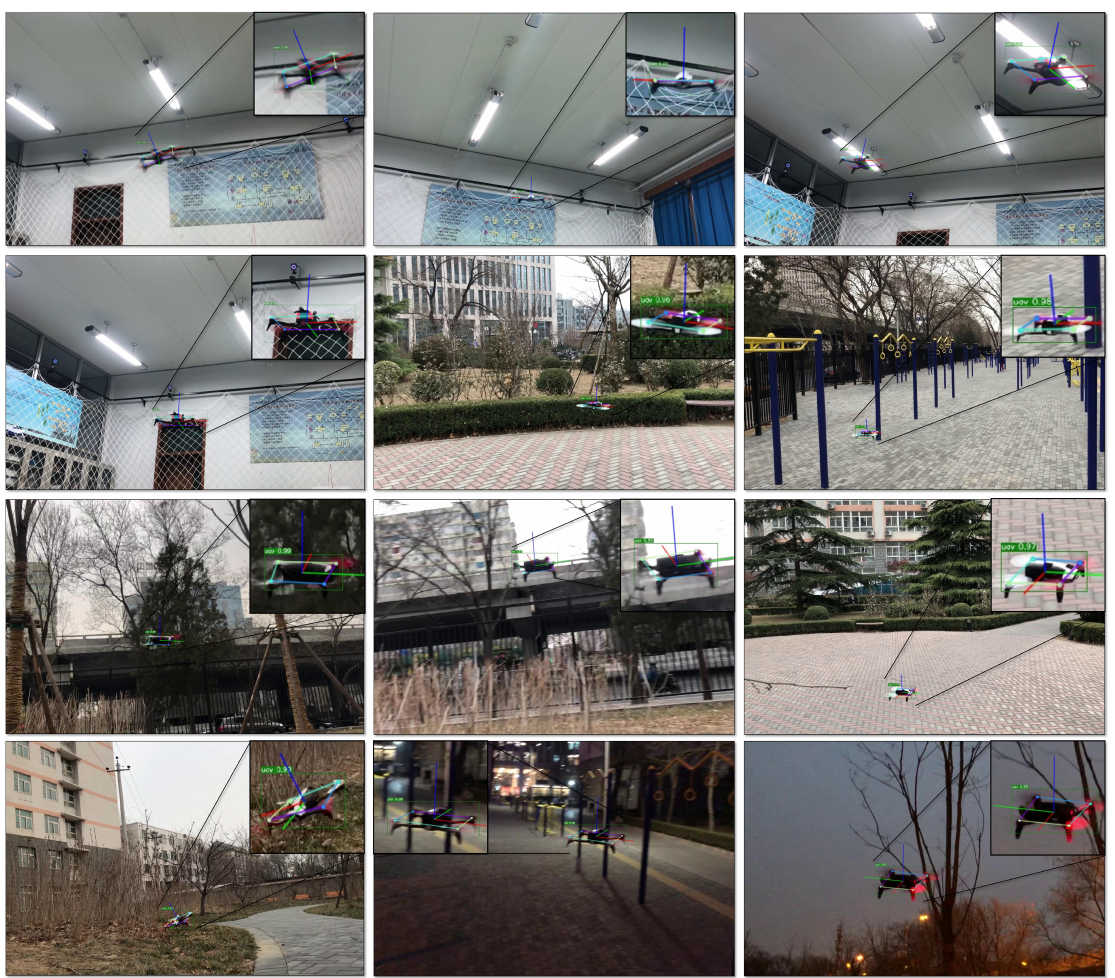
Figure 11. Representative results of quadrotor pose estimation by our relational graph keypoints detection model and PnP algorithm. It can be seen that the quadrotor pose can be estimated from a variety of observation